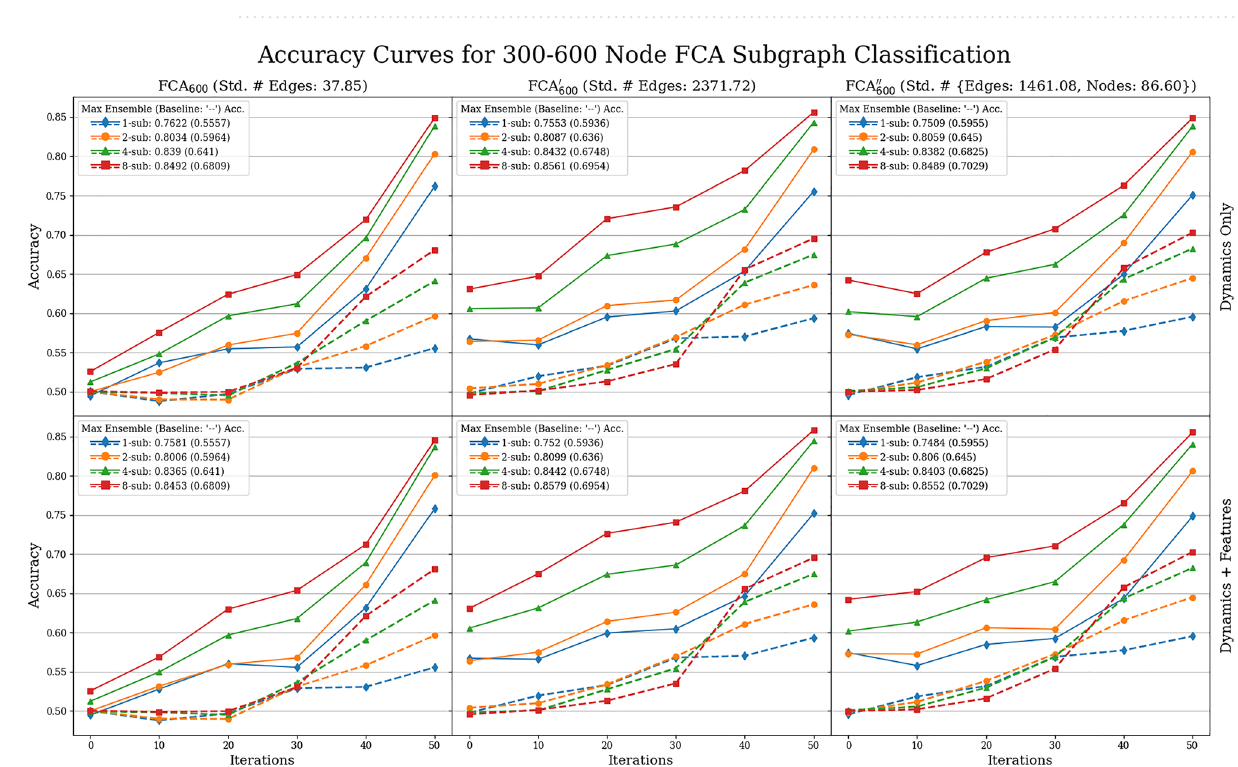
Figure 7. Accuracy curves for predicting synchronization of 5-color FCA on 600-node graphs from dynamics observed from k ∈ { 1, 2, 4, 8 } subgraphs of 30 nodes. See the caption of Fig. 6 for